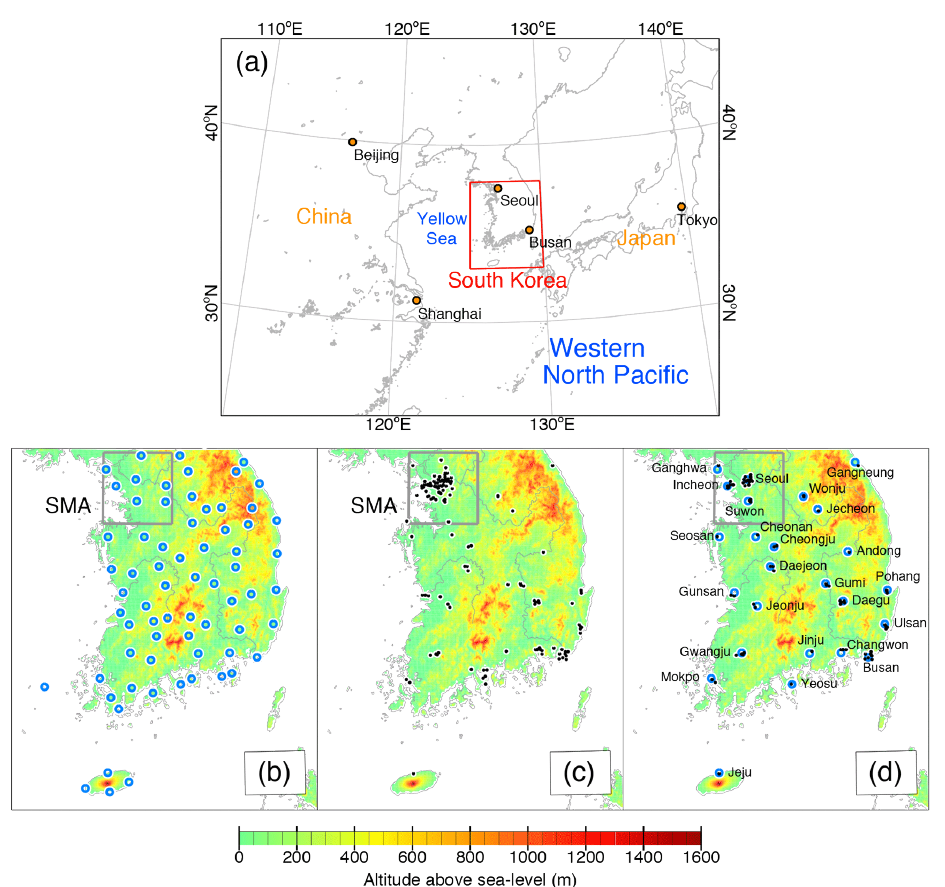
Figure 2. (a) Geographical location of South Korea, (b) 72 weather stations of the Korea Meteorological Administration (KMA) as blue circles, (c) 124 air quality monitoring sites of the National Institute of Environmental Research (NIER) as black dots, and (d) 72 air quality monitoring sites of NIER, which are located within 10km from 25 weather stations of KMA over the South Korean domain.